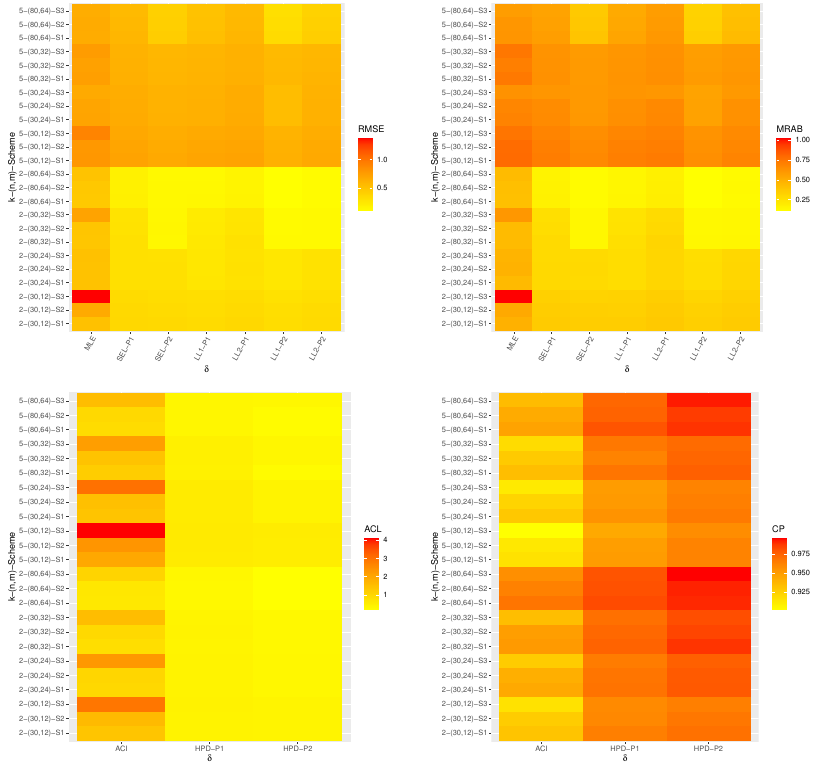
Figure 2. Heatmap plots for classical and Bayesian estimation results of δ .